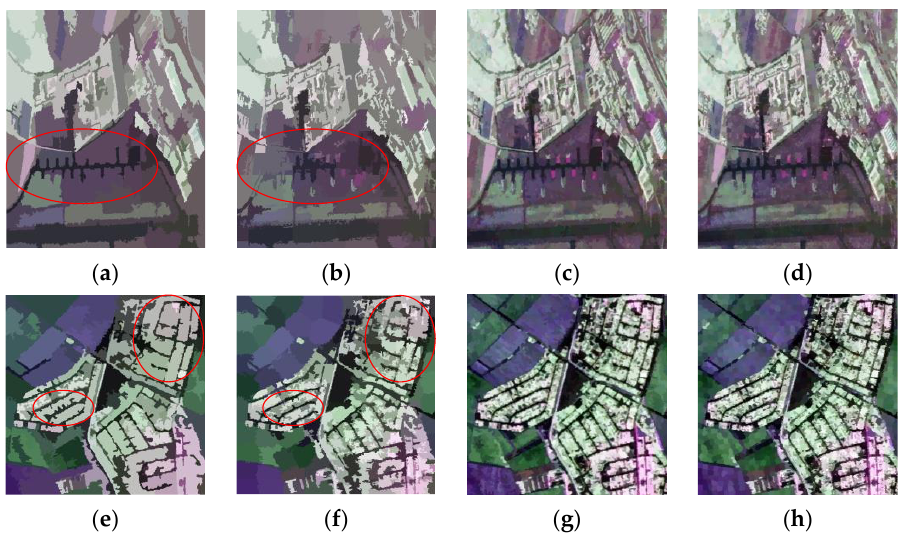
Figure 11. The segmentation results of different scales from the proposed method and Pol-ASLIC. The first row is based on ESAR data and the second is based on AIRSAR data; ( a ) and ( e ) results from the proposed method and K = 100; ( b ) and ( f ) results from Pol-ASLIC and K = 100; ( c ) and ( g ) results from the proposed method and K = 2500; ( d ) and ( h ) results from Pol-ASLIC and K = 2500.